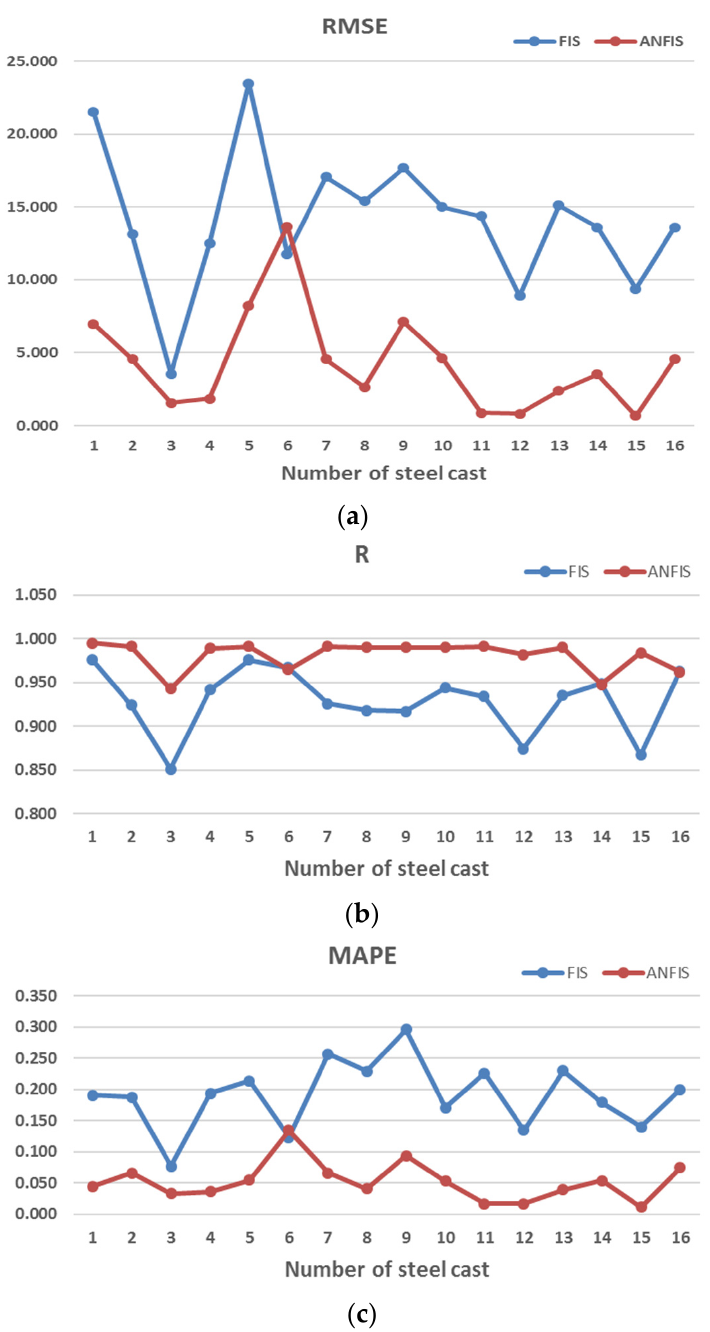
Figure 6. Measuring the diagnostic accuracy for all steel casts with valve clogging: ( a ) comparing RMSE parameter values obtained with fuzzy inference system (FIS) and ANFIS; ( b ) comparing R parameter values obtained with FIS and ANFIS; ( c ) comparing MAPE parameter values obtained with FIS and ANFIS.